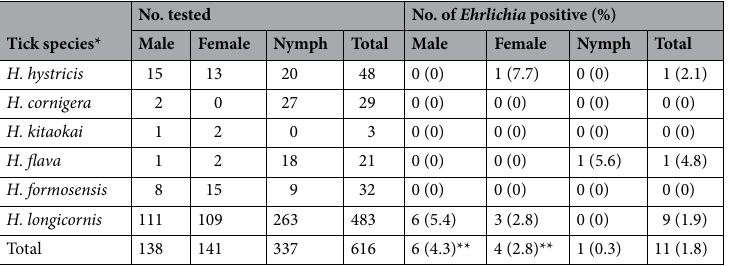
Table 1. Detection of uncultured Ehrlichia bacteria from ticks by p28 -PCR screening. * H : Haemaphysalis. **Statistical significance of the 10 positive adult ticks (females + males) vs one positive nymph using Fisher’s extract test ( p =